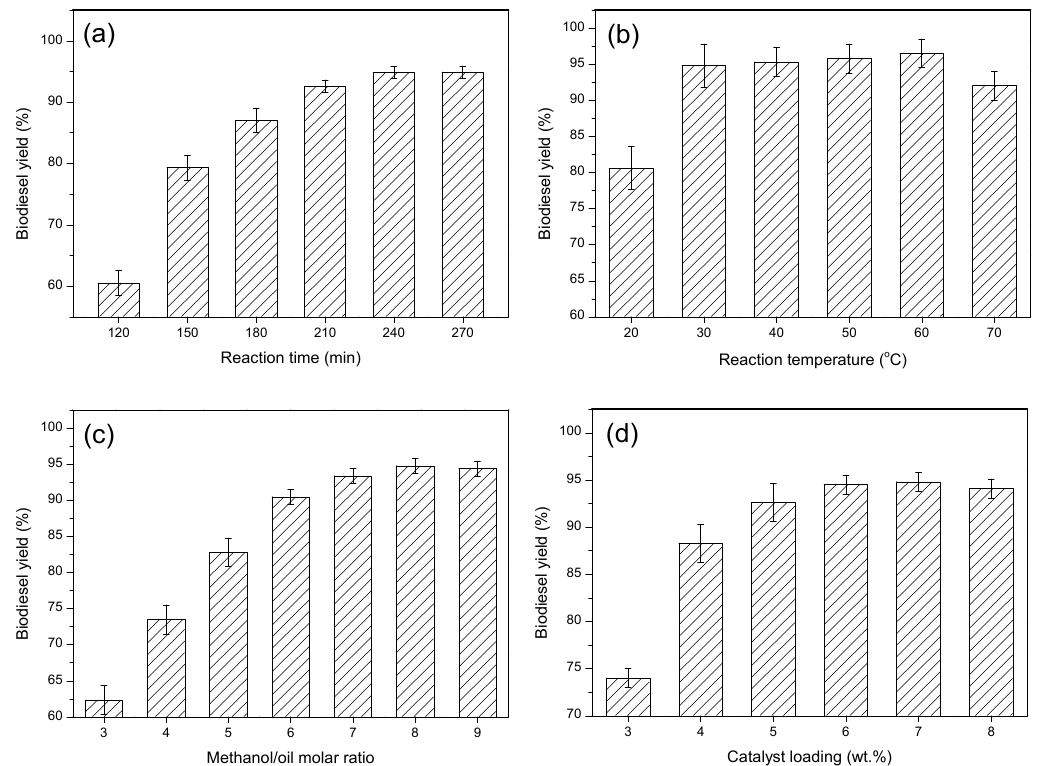
Figure 6. Influence of reaction conditions on the transesterification reaction: ( a ) reaction time, ( b ) reaction temperature, ( c ) methanol/oil molar ratio and ( d ) catalyst loading.